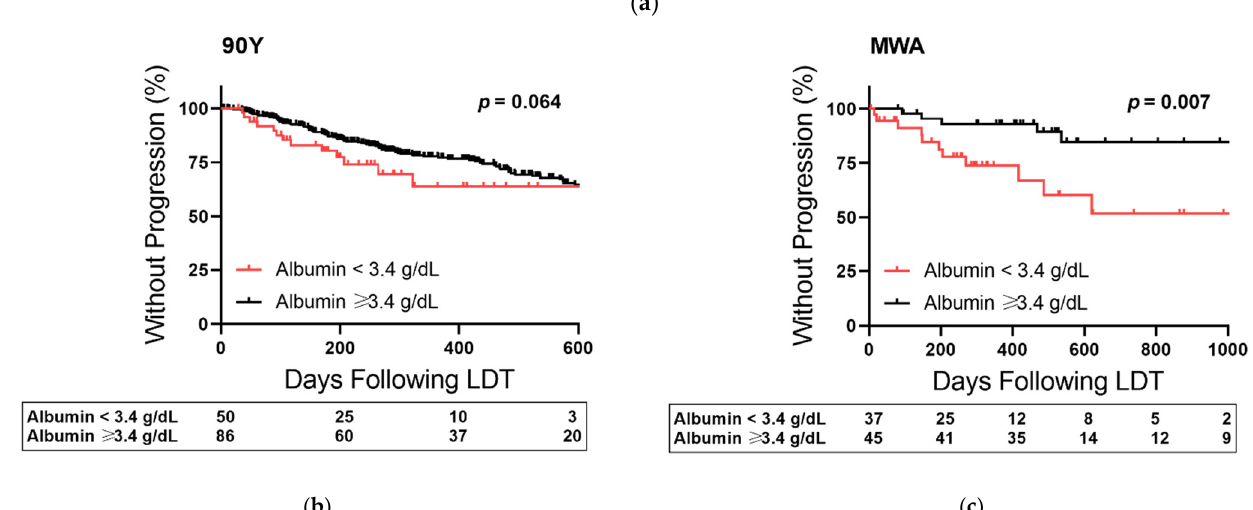
Figure 5. Albumin-Stratified Kaplan–Meier Curves of Time to Progression Based First Cycle Liver- Directed Therapy (LDT) Treatment Modality. ( a ) Plot restricted to patients treated with drug-eluting embolic transarterial chemoembolization (DEE-TACE). ( b ) Plot restricted to patients treated with Yttrium-90 (90Y). ( c ) Plot restricted to patients treated with microwave ablation (MWA). Censored data is marked with a vertical upward dash. The total number of patients remaining in the analysis at each major x-axis time point is listed in the table below the plot. Significance was determined using the Log-Rank test.